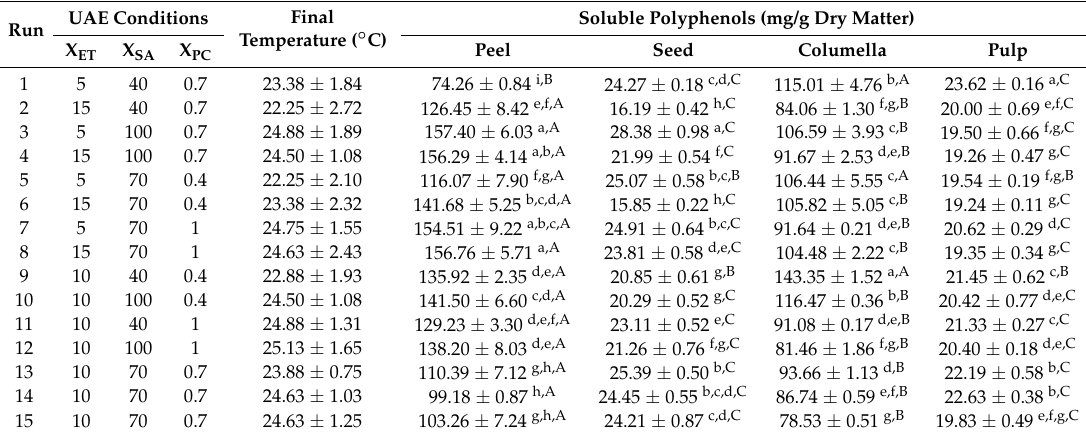
Table 1. Effect of process variables of ultrasound-assisted extraction on soluble polyphenols from peel, seeds, columella, and pulp from soursop